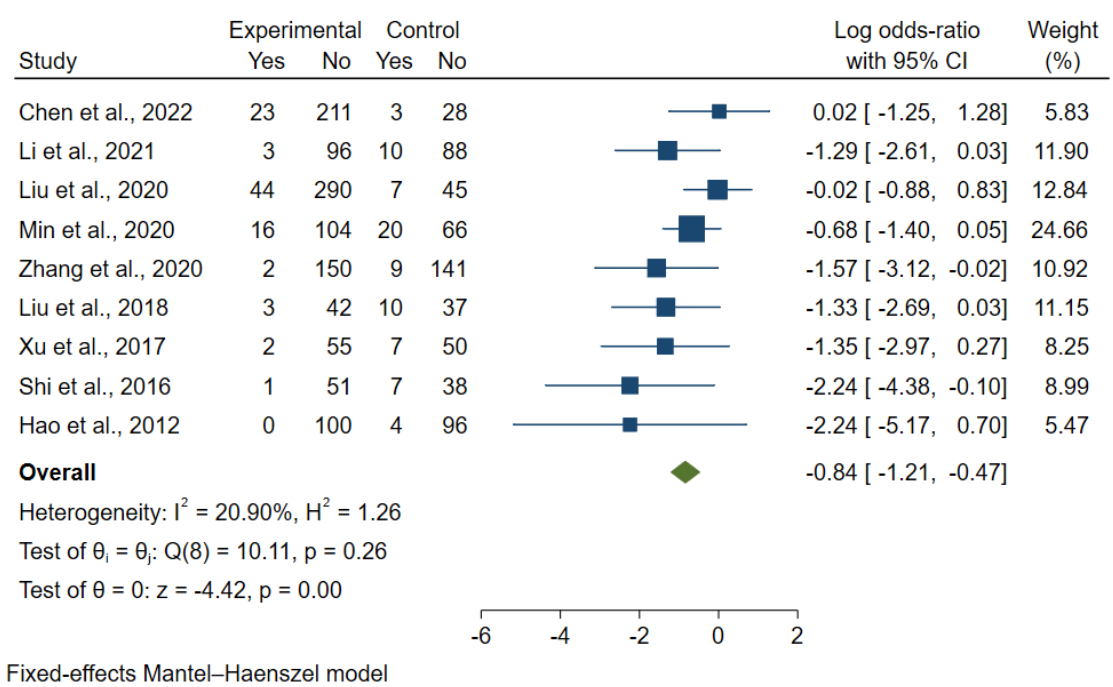
Fig. 4. The forest plot showed an odds ratio of Parathyroid glands removed